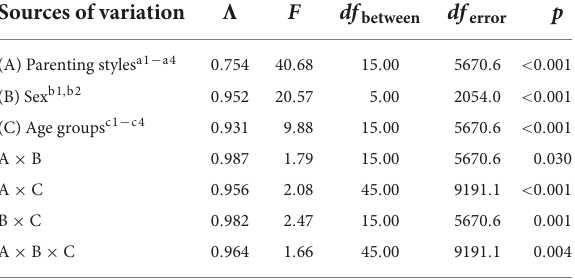
TABLE 2 MANOVA (4 a × 2 b × 4 c ) for self (family self-concept, self-esteem, and negative self-adequacy), universalism values, and emotional